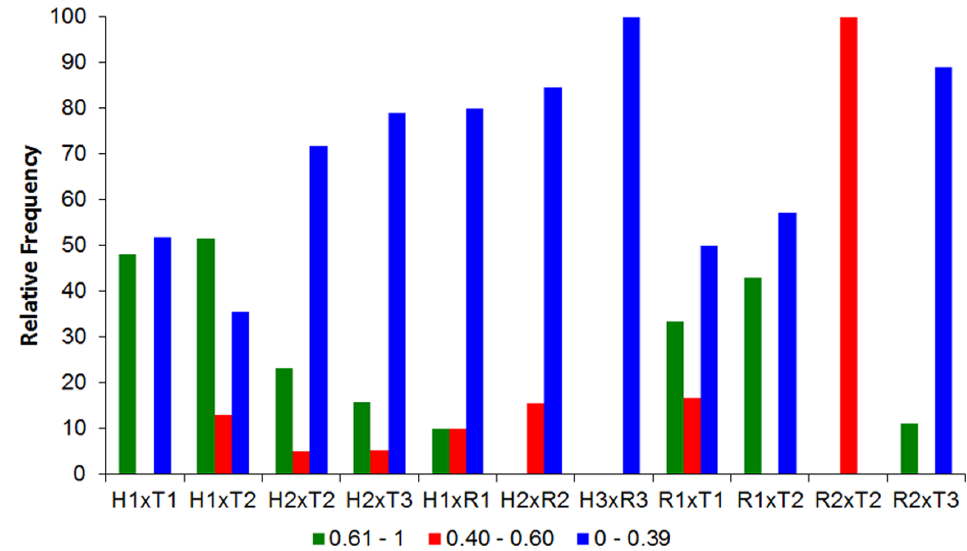
Figure 6. Pianka’s index results. Relative frequency of Pianka’s index of all pairwise interactions between the species with compatible size classes per sampling unit. For specie/size class code see Table 1.